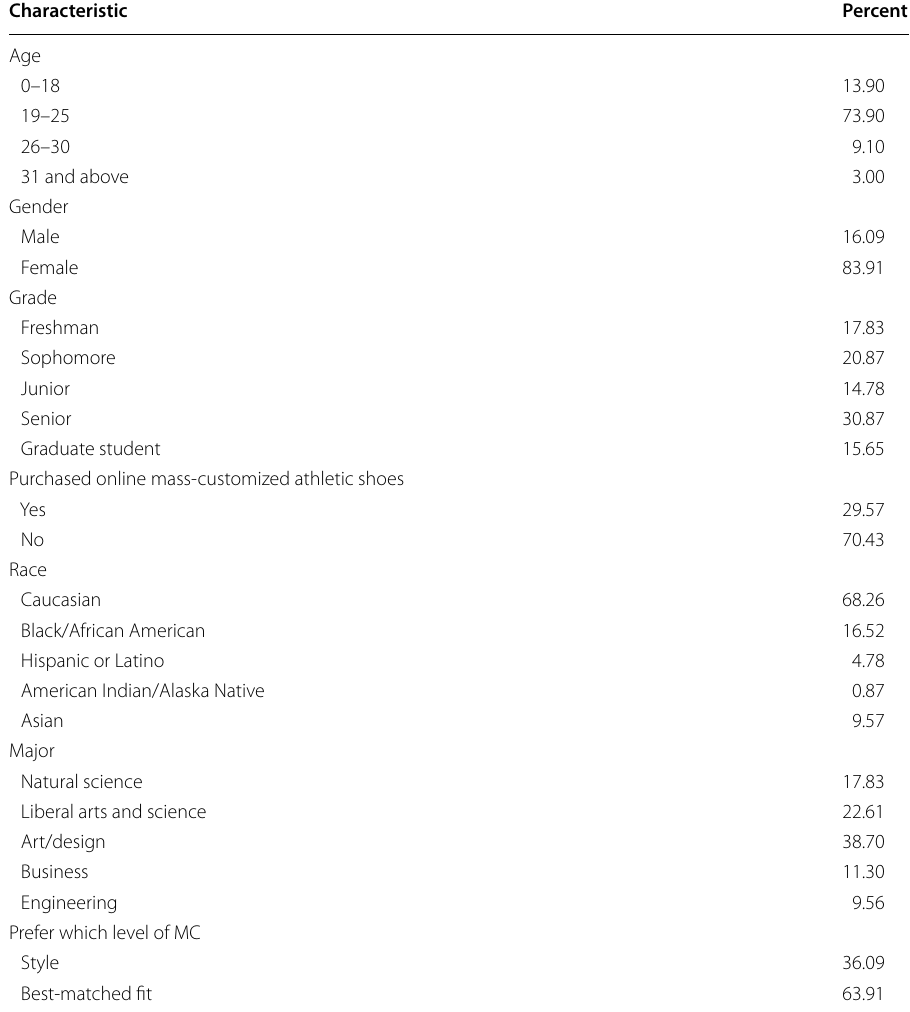
Table 1 Demographic profiles of